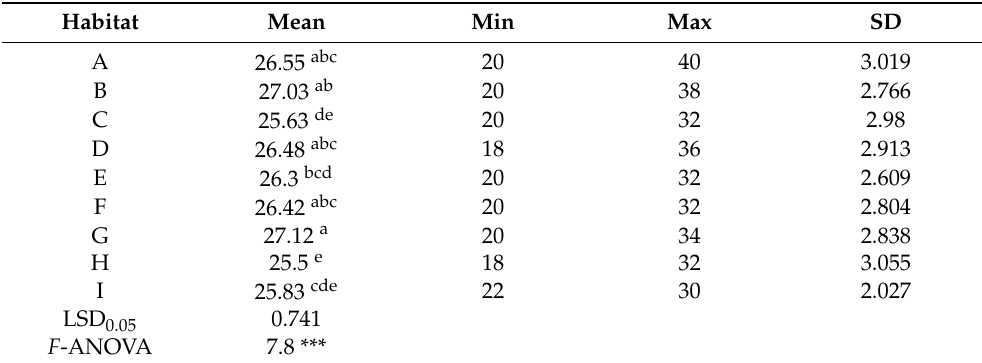
Table 4. Mean values, minimal, maximal and standard deviations (SD) as well as homogenous groups for length of the shortest polar axis (SA), A–I abbreviated habitat names (see: Table 1).